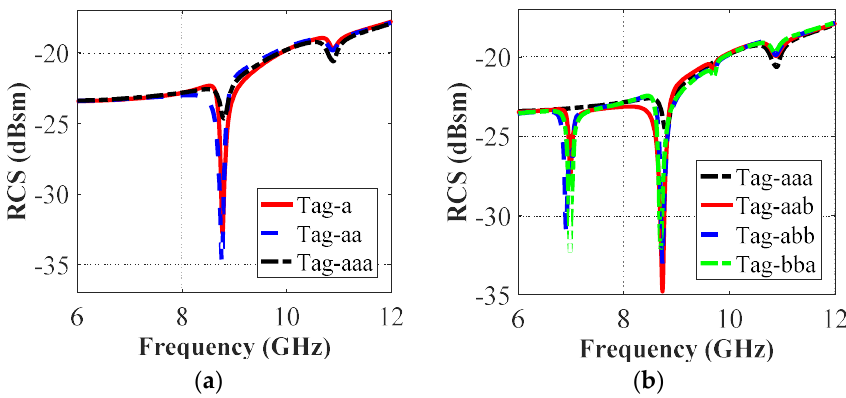
( b ) Figure 8. Co-polar RCS simulation results of tag-abc ( a ): Co-polar HH RCS responses; ( b ) Co-polar VV RCS responses. ( a ) ( b ) Figure 9. Co-polar RCS simulation results of tag-abc with and without the ground plane under the tag structure ( a ): Co-polar HH RCS responses; ( b ) Co-polar VV RCS responses. The effect of the change in the resonance properties of the letter-tag with the variations in its position and its repetition is illustrated in Figure 10, which shows that the location modification or